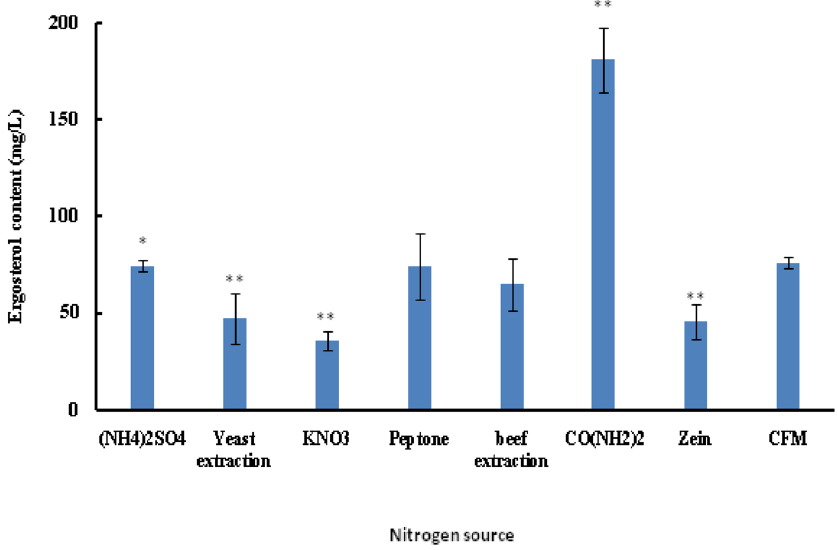
Figure 1. Effects of various nitrogen sources on the yield of extracellular ergosterol. CFM is the control fermentation